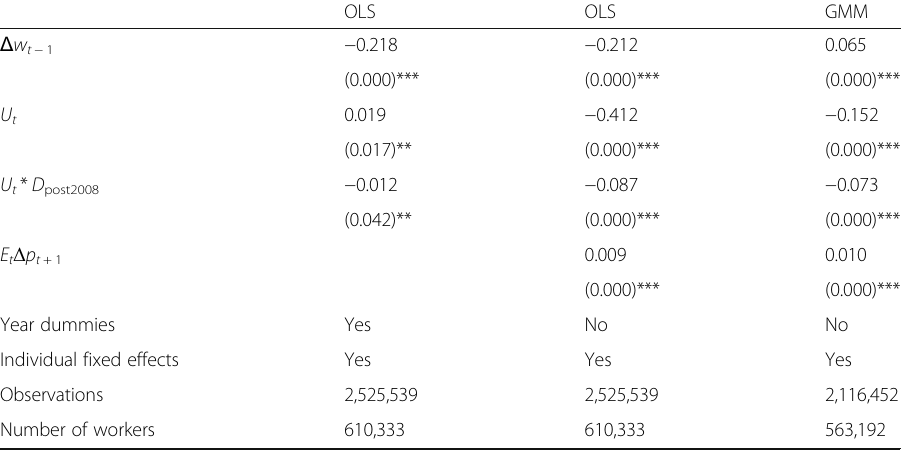
Table 6 Wage Phillips curve in Italy: individual estimates; job movers ( p values in brackets) OLS OLS GMM Δ w t −